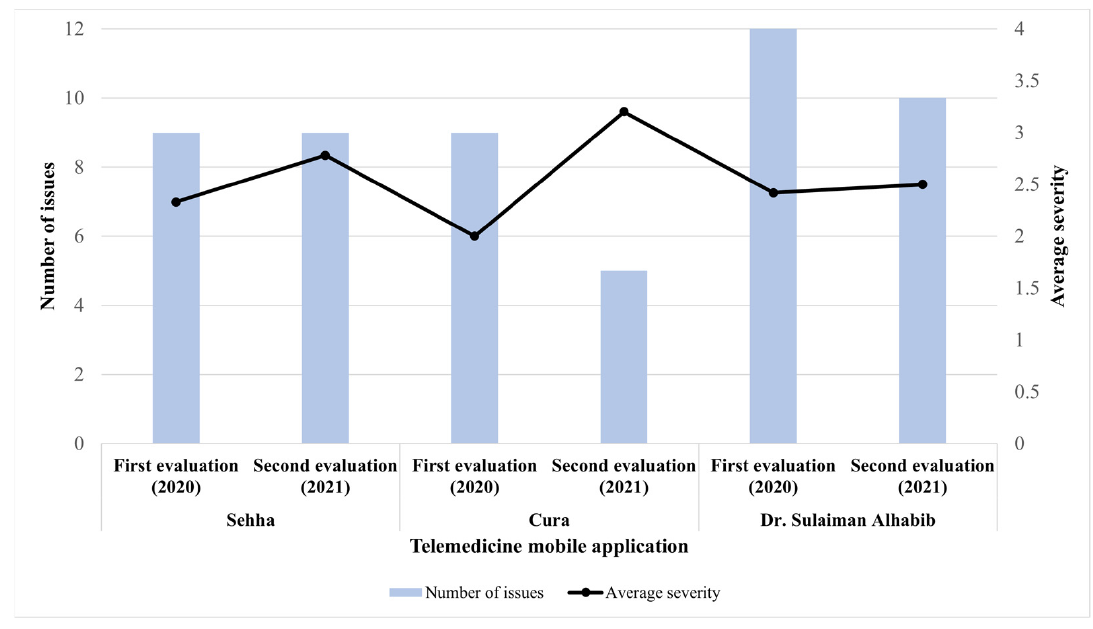
Figure 1. Frequency and average severity ratings by evaluation period among the three apps.